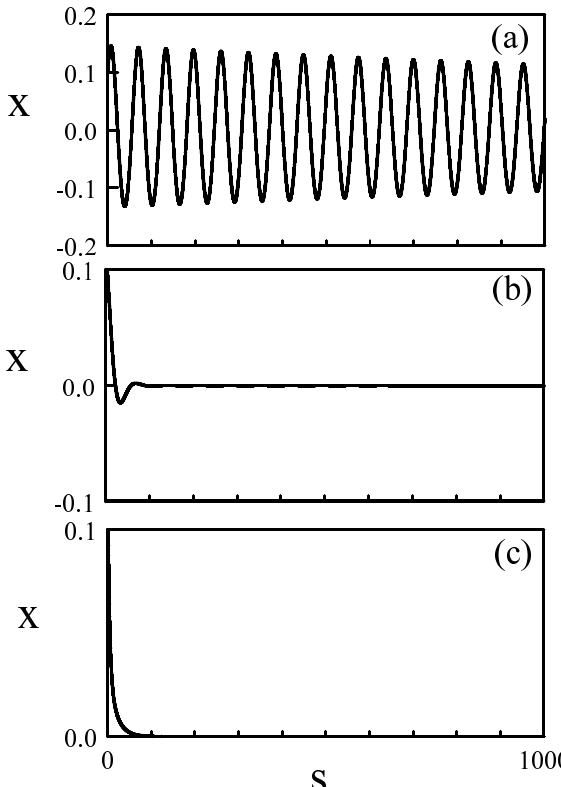
Figure 5. Stabilizing effect of the delayed feedback. Equations (3) and (4) have been simulated numerically with increasing values of η and with the initial conditions x ( 0 ) = 0.1 and y = 0 ( − θ < s ≤ 0 ) . The fixed parameters are θ = 0.1, ε = 2.45 × 10 − 3 , I s = 1. ( a ) η = 0, ( b ) η = 1, ( c ) η =